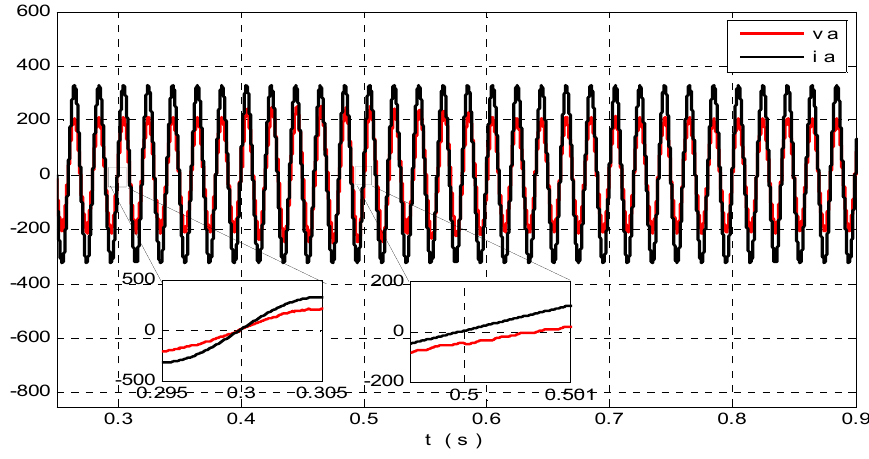
Electronics 2018 , 7 , x FOR PEER REVIEW Figure 26. Voltage and current signals (phase a). Figure 26. Voltage and current signals (phase a).